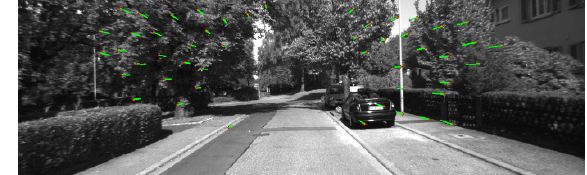
Figure 10. Sample image of ideal feature movement